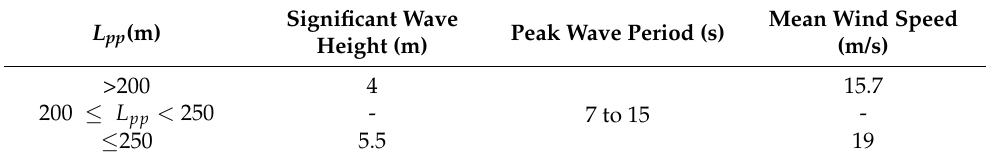
Table 13. Adverse weather conditions [18,19].